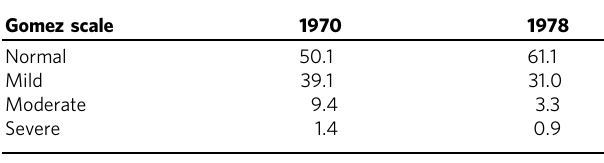
Table 2 Nutritional status of children aged 0 – 4, 1970 – 1978. Gomez